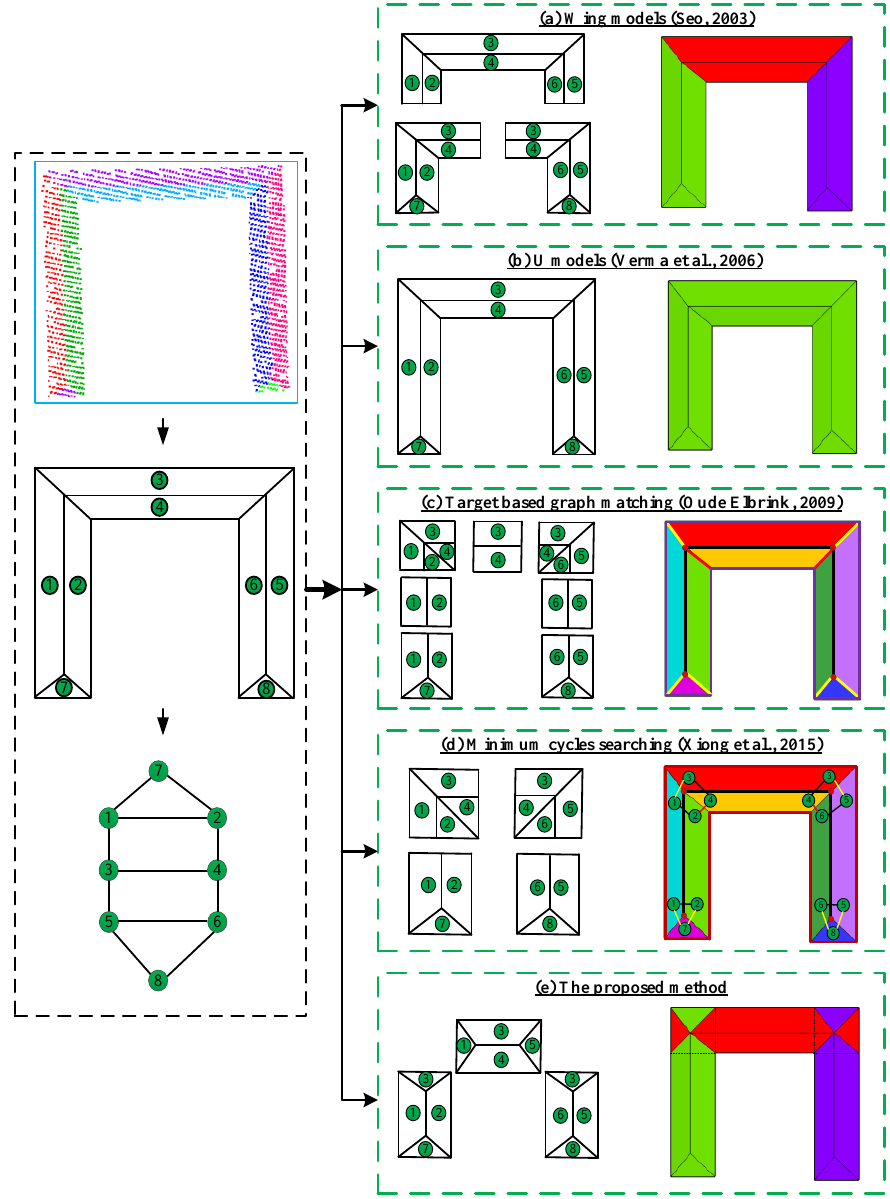
Figure 13. Decomposition results of different building reconstruction methods using roof topology graph. Left : the rooftop segmentation results, the number of the segmented planar patches and the corresponding roof topology graph. Right : the decomposition results and the reconstructed 3D building models. ( a ) The decomposition result of the reconstruction method proposed by Seo [12]; ( b ) the decomposition result of the reconstruction method proposed by Verma et al. [22]; ( c ) the decomposition result of the reconstruction method proposed by Oude Elberink and Vosselman [37]; ( d ) the decomposition result of the reconstruction method proposed by Xiong et al. [52]; and ( e ) the decomposition result of the proposed